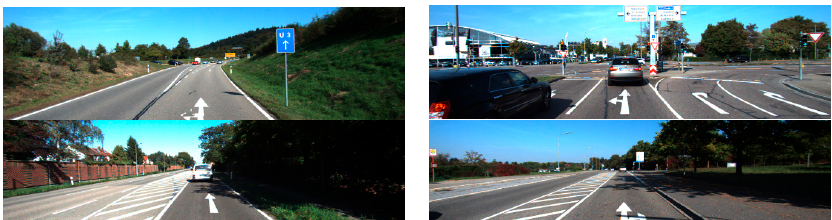
Figure 8. Example images from Road/Lane detection evaluation 2013 dataset.